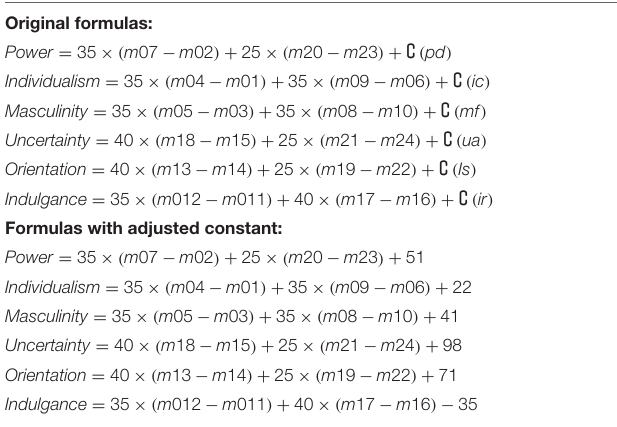
TABLE 2 | Cultural dimensions’ formulas.